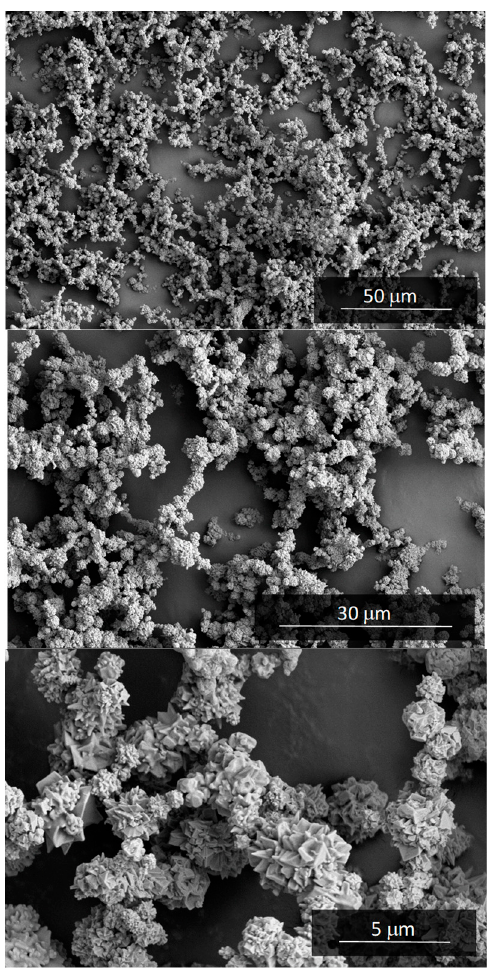
Figure 5. SEM micrographs (Fei Teneo) of the Ni Type 255 powder used for MF-ERS experiments.